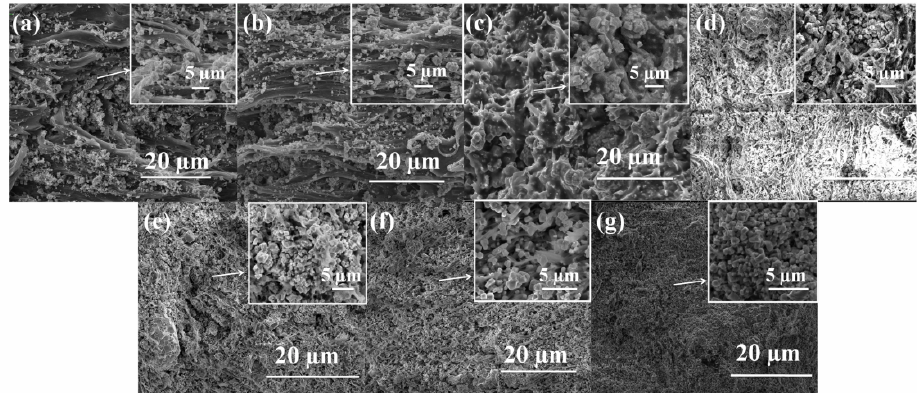
Fig. 5 Fractured cross-sectional SEM micrographs for hot-pressed PVDF–KNN microcrystal composites: (a) PVDF–10 vol% KNN, (b) PVDF–20 vol% KNN, (c) PVDF–30 vol% KNN, (d) PVDF–40 vol% KNN, (e) PVDF–50 vol% KNN, (f) PVDF–60 vol% KNN, (g) PVDF–70 vol% KNN, and the insets show the enlarged view of the corresponding